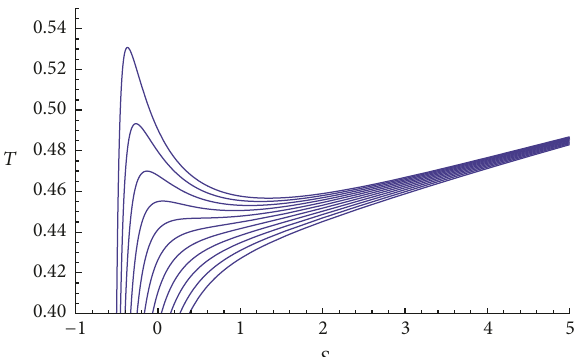
Figure 1: Relations between temperature and thermal entropy for different 𝑒 with 𝑞 = 0.05 ; curves from top to down correspond to cases 𝑒 varying from 0.1 to 0.2 with step 0.01.